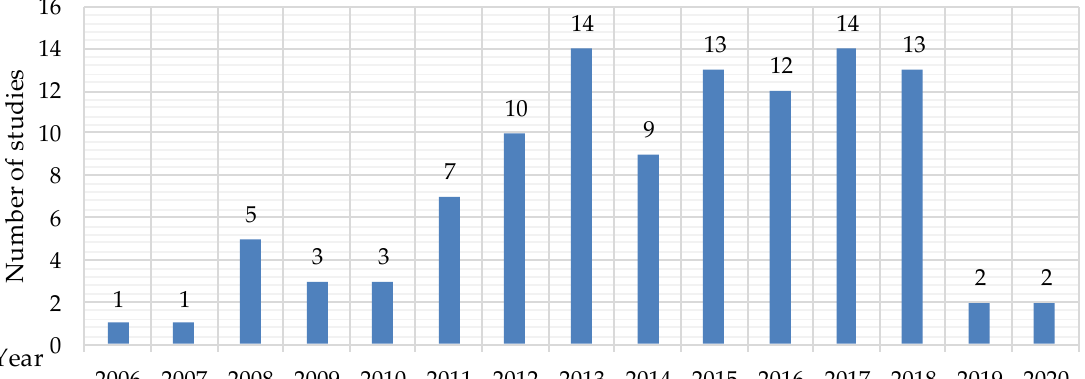
Figure 1. Year-wise distribution of selected studies.